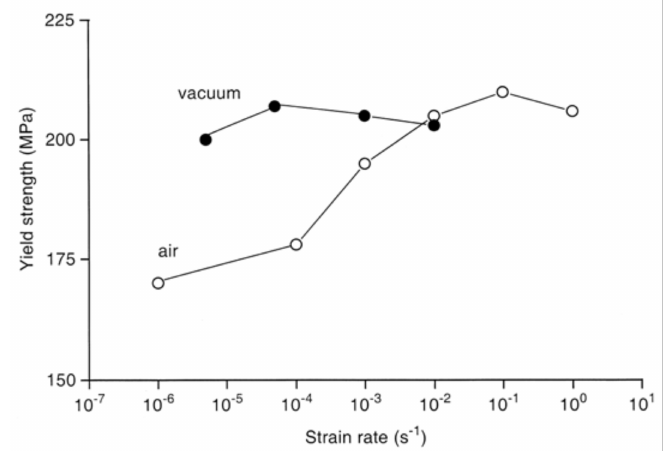
Figure 22. Yield strength versus strain rate for as-annealed Fe-40Al single crystal alloy tested in either air or a vacuum. Reprinted with permission from ref. [33]. Copyright 2001 Elsevier.